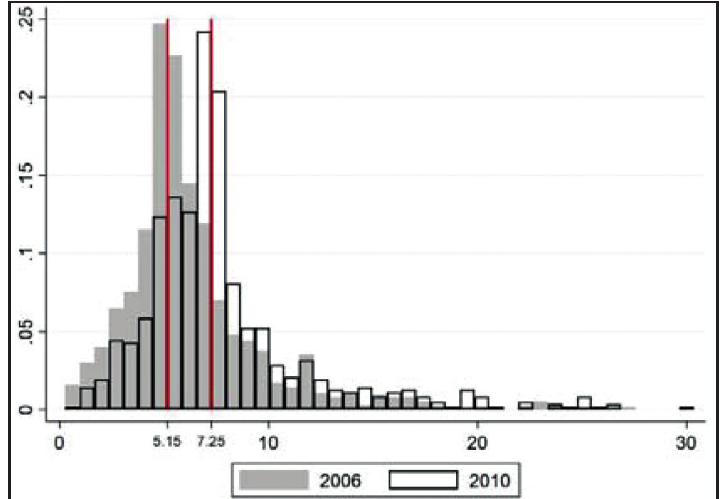
Distribution of Wages for Workers Aged 15–24 in Puerto Rico in 2006 and